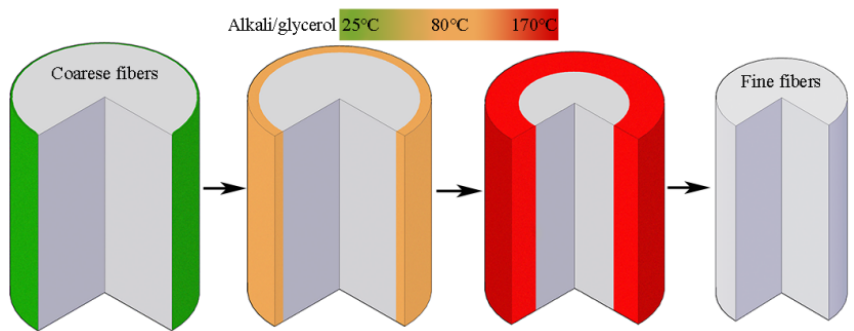
Figure 4. Schematic diagram of the limited alkali penetration in cotton stalk fibers.